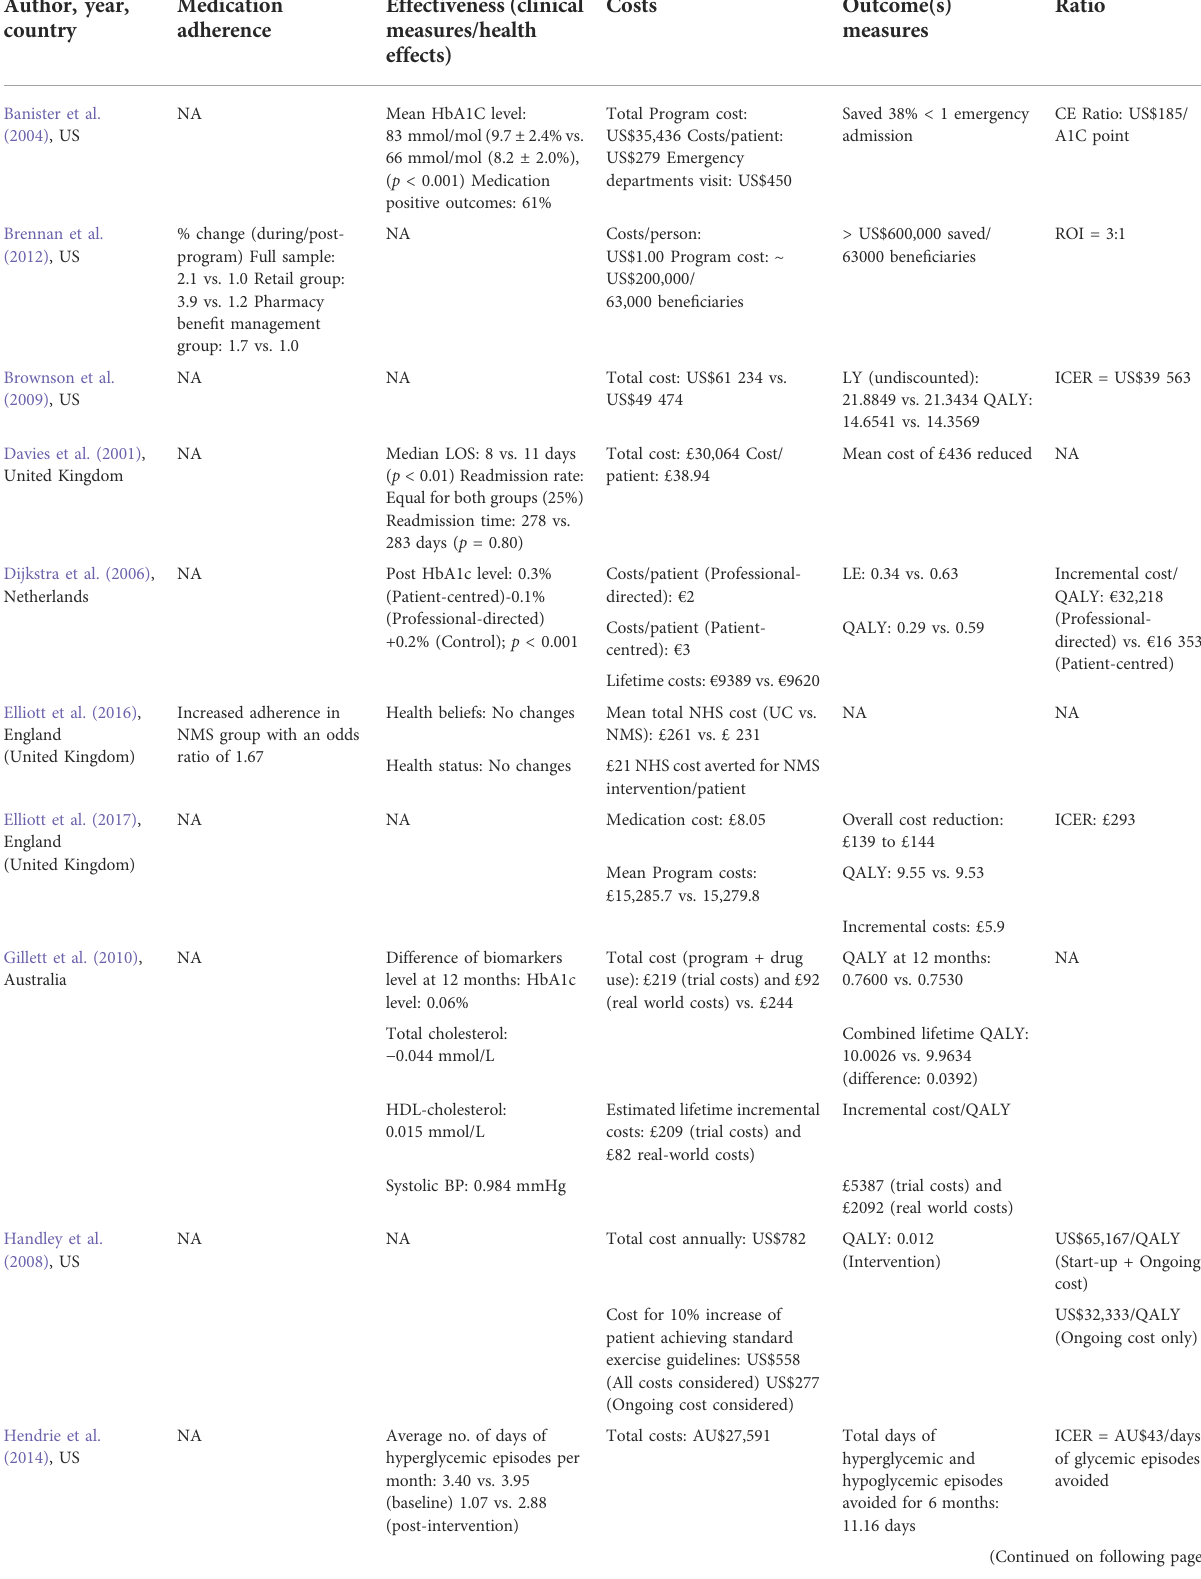
TABLE2Effectivenessandeconomicoutcomesofasystematicreviewofthecost-effectivenessofdifferenttypesofeducationalinterventionsintype II diabetes